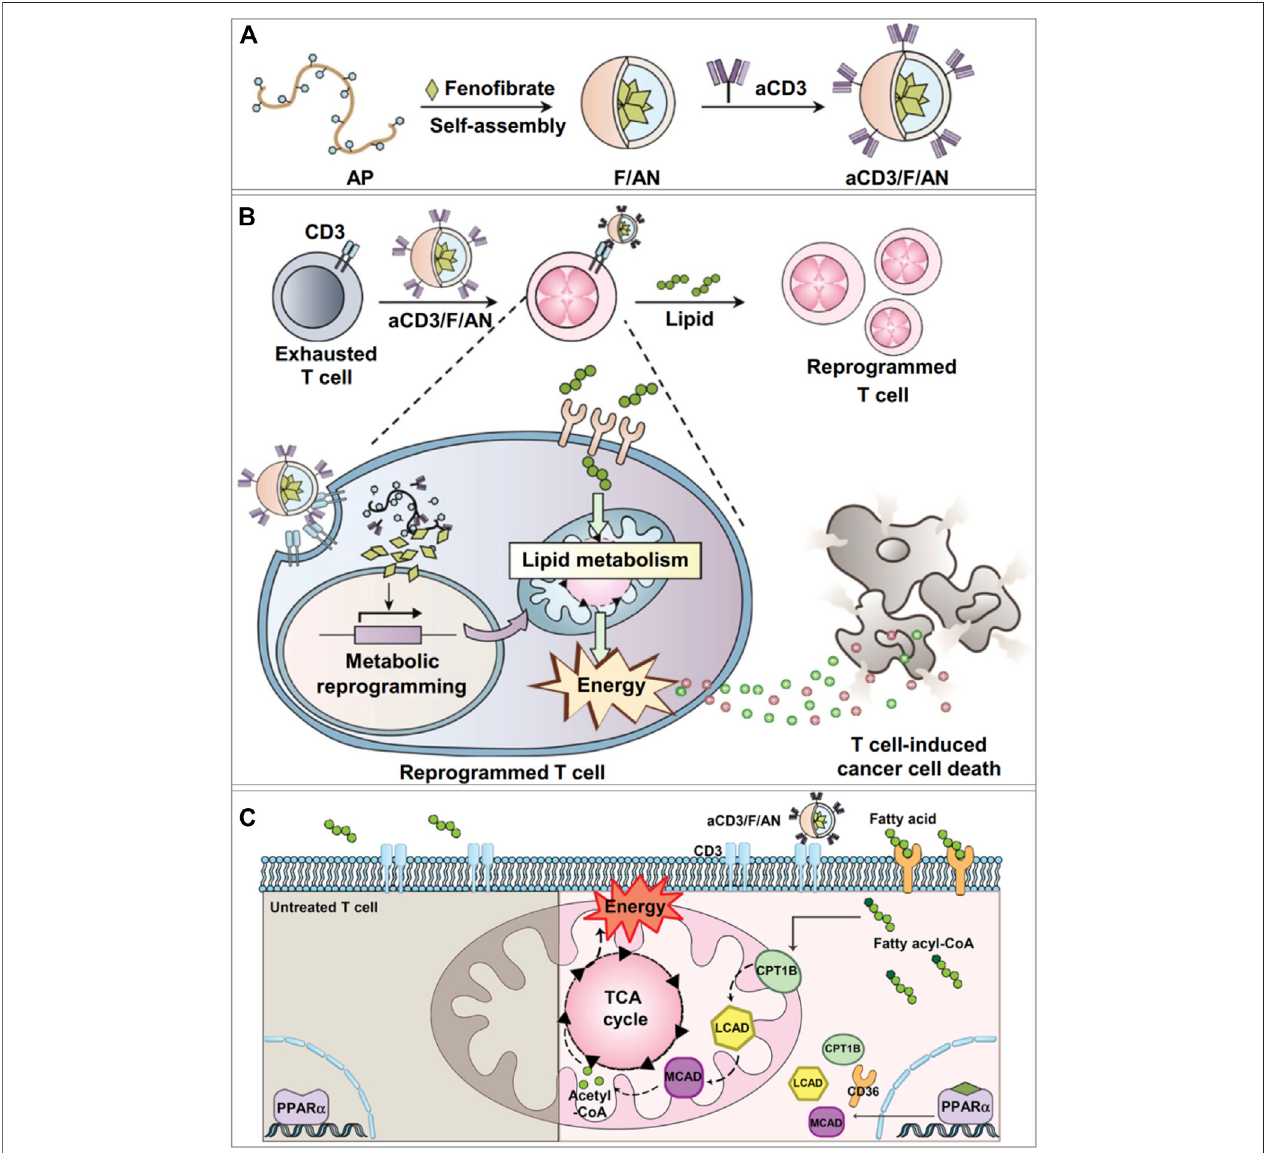
FIGURE 2 | aCD3/F/AN mediated lipid metabolic reprogramming in T cells for immune-metabolic therapy (Kim D. et al., 2021). (A) Preparation of aCD3/F/AN nanoparticles. (B) The ability of T cells to kill tumors is enhanced by the activation of mitochondrial fatty acid metabolism. (C) Mechanisms of fatty acid metabolism activationinTcells.ThelefthalfoftheschematicpicturedepictstheuntreatedTcells.Intherightpanel, itshowsthataCD3/F/ANsenhanced themitochondrialfattyacid metabolism by upregulating the expression of fatty acid metabolism-associated proteins, e.g., CD36, CPT1B, LCAD, and MCAD. Reprinted under the Creative Commons CC BY